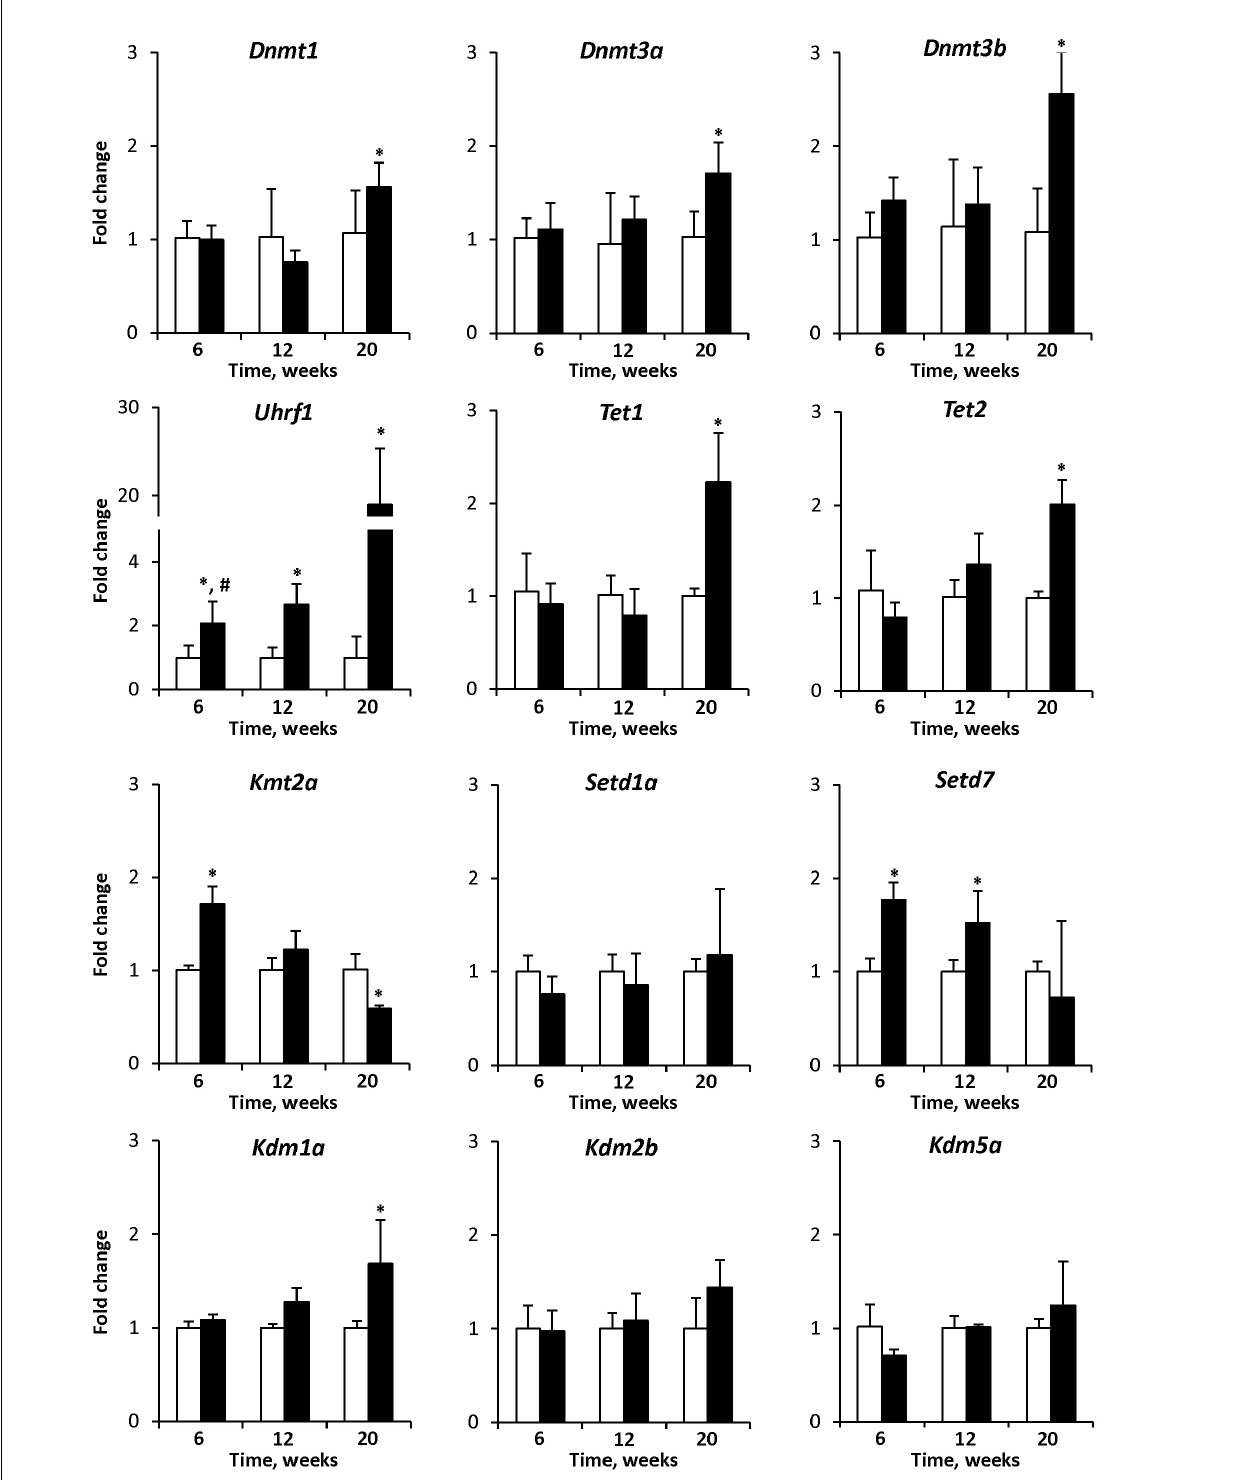
FIGURE 5 | The expression of chromatin modifying genes in the livers of control mice and STAM mice subjected to NASH-derived hepatocarcinogenesis. The results are presented as an average fold change in the expression of each gene in the livers of STAM mice at 6, 12, and 20 weeks relative to that in control age-matching mice. The data are presented as the mean ± SD; n = 4. ∗ Denotes a significant ( P < 0.05) difference from the control age-matching group; # denotes significant ( P < 0.05) trend.